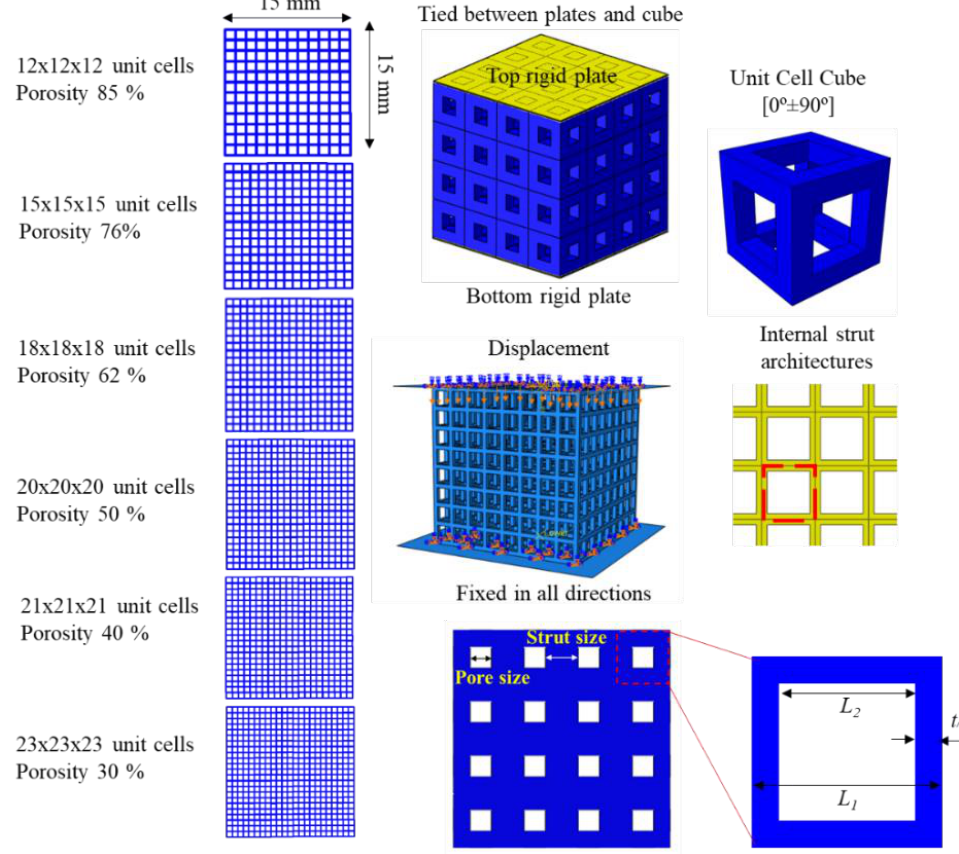
Figure 1. Porous structure designs along with finite element model to study the mechanical properties.